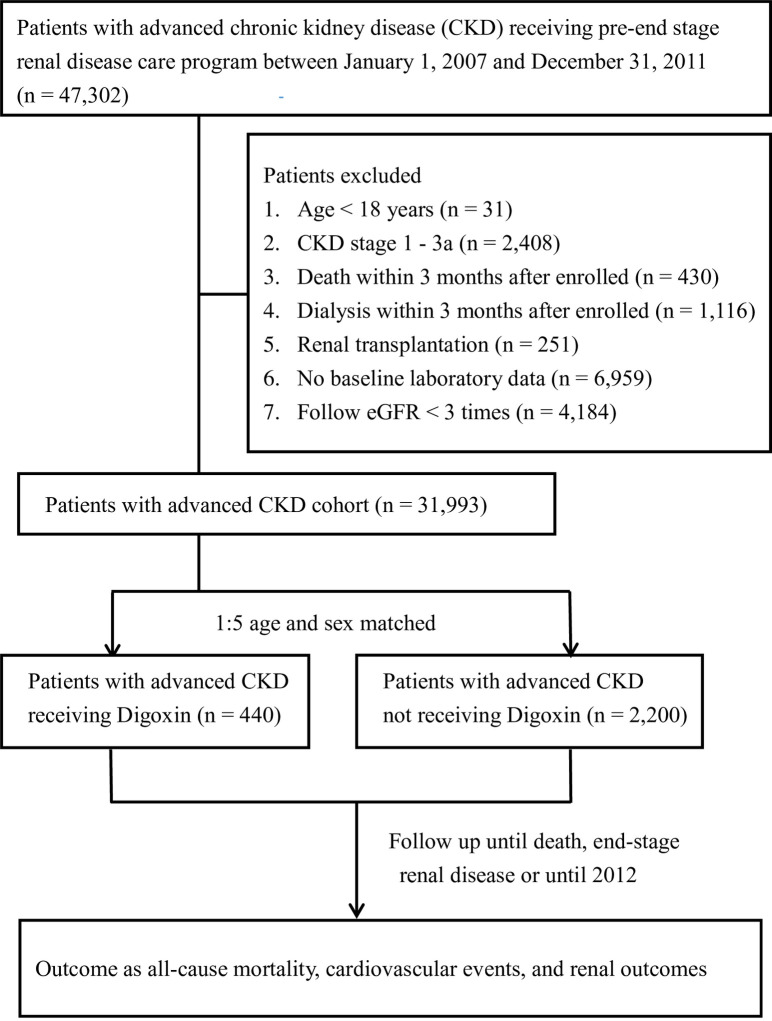
Study flowchart.